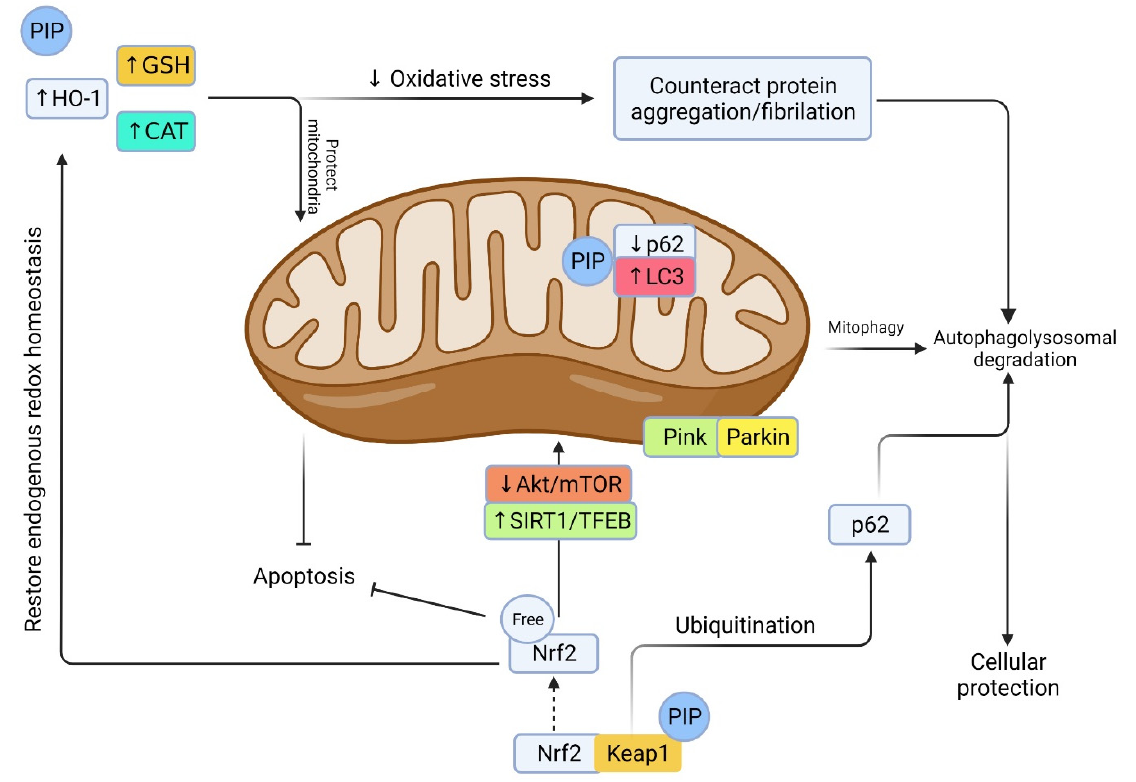
Figure 4. Prospective machinery of PIP in oxidative stress-induced neurodegenerative events. Oxidative stress arises from a decrease in endogenous antioxidant defense including HO-1, GSH, CAT, and Nrf2. This leads to a cascade of events including protein oxidation/glycation/mitochondrial damage, protein aggregation, and impaired autophagy/lysosome vacuoles. PIP is a potential antioxidant that could induce oxidative stress via promoting antioxidant defense, reducing ROS, and preserving mitochondrial integrity. On the other hand, Keap1 degradation and Nrf2 activation by PIP could counteract oxidative stress, reduce mitochondrial damage, promote autophagy by degrading/ubiquitination of p62/sequesterosome, promote autophagic flux by converting microtubule-associated protein 1A/1B-light chain 3 (LC3), promote mitophagy and mitobiogenesis via distinct pathway, and rescue from cellular apoptosis and degeneration [74].